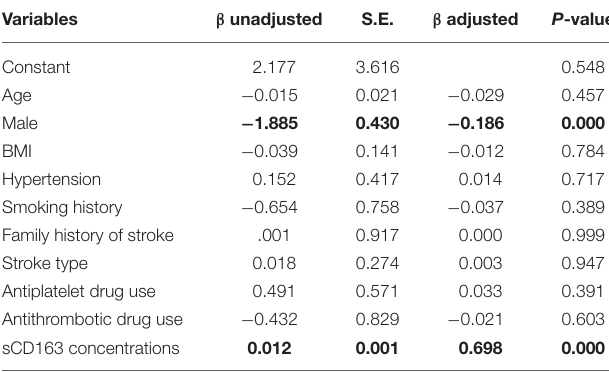
TABLE 3 | A linear regression model to evaluate the association between plasma sCD163 levels and functional improvement during follow–up.